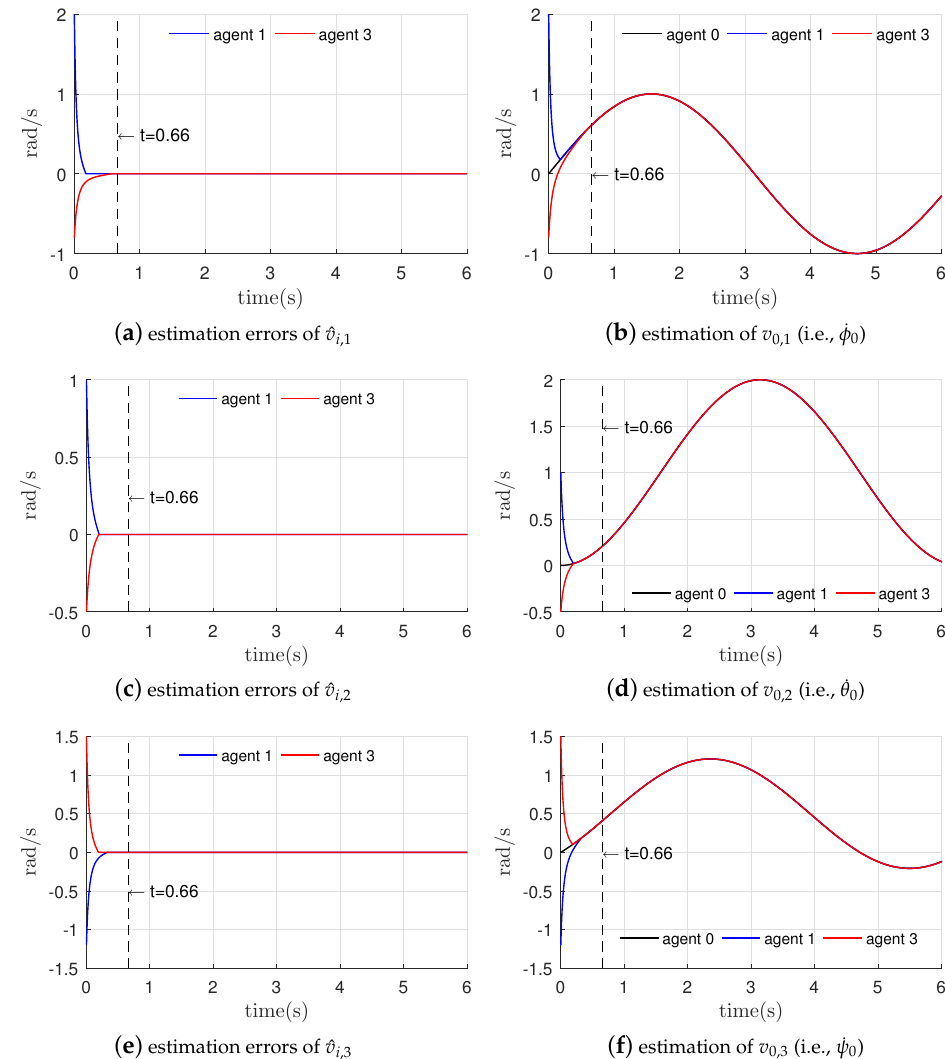
Figure 4. Estimation errors of the REDFTO for agents i = 1 and i = 3.